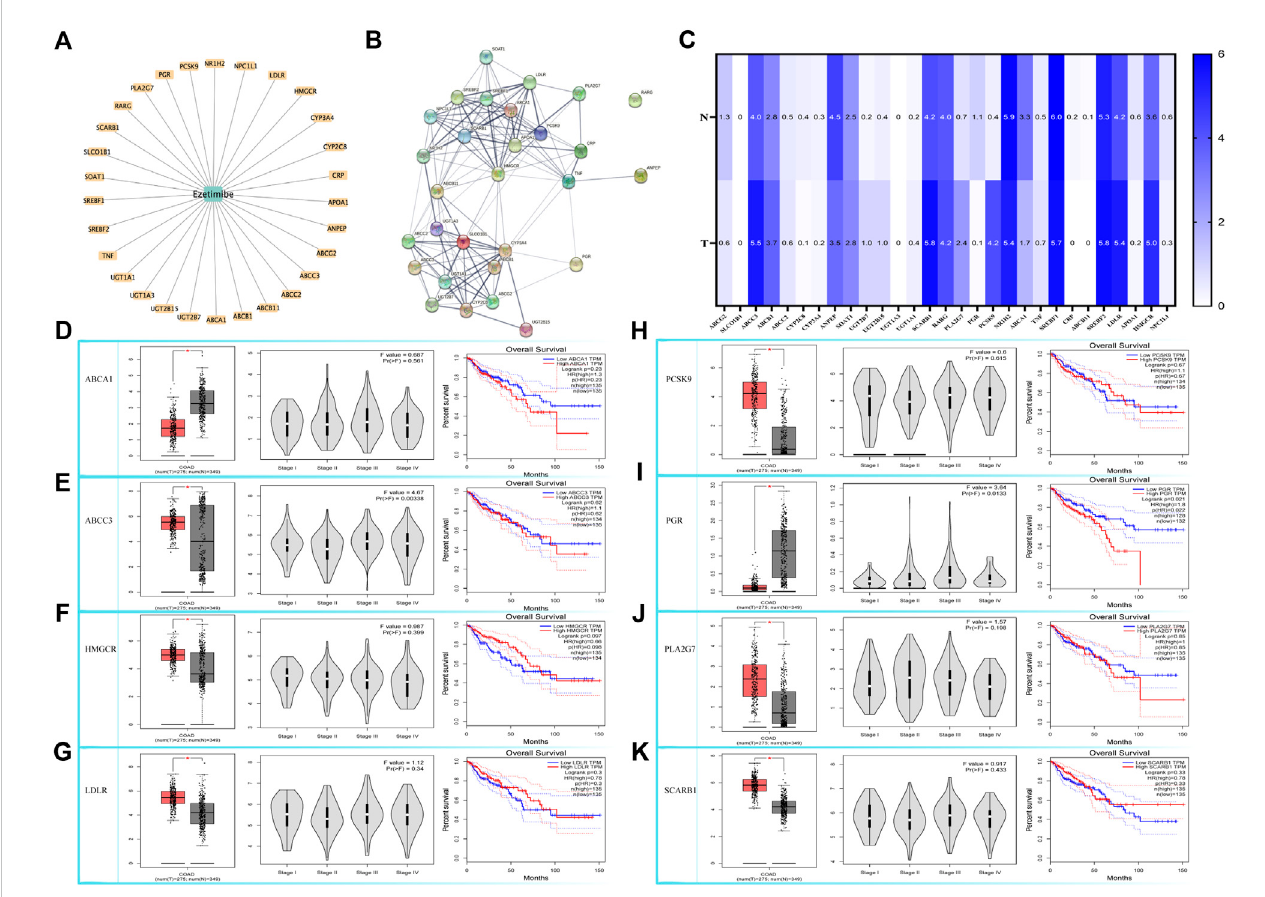
FIGURE 3 Bioinformatic based explorations of ezetimibe targeted genes and clinical correlations for CRC related ones. (A) The Comparative Toxicogenomics Database and Drugbank online based retrieval of targeted genes for ezetimibe. (B) Protein string for the retrieved targeted genes. (C) The Gene Expression Pro fi ling Interactive Analysis (GEPIA) based expression fold changes between tumor and normal tissue in CRC patients. (D – K) GEPIA based CRC related expressed genes (ABCA1, ABCC3, HMGCR, LDLR, PCSK9, PGR, PLA2G7, SCARB1) and the correlations with their expressions to CRC stages, and to CRC overall survival. * p <